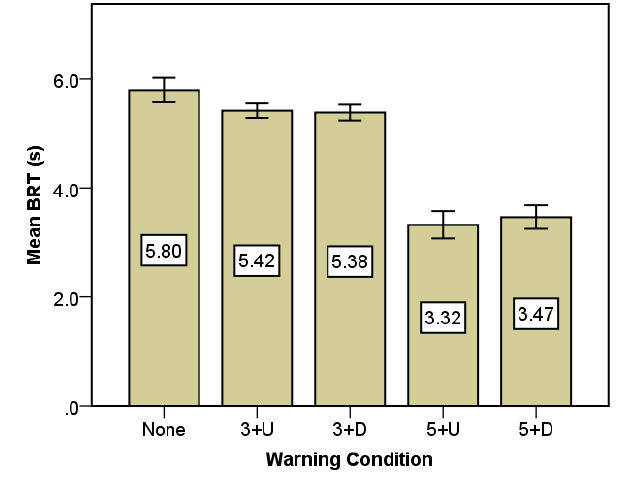
Figure 5 . Mean BRT under different warning conditions.